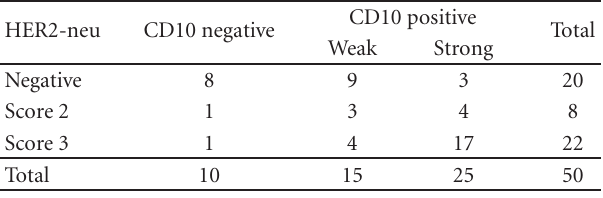
Figure 4: Strong CD10 stromal staining. Table 4: Correlation of CD10 with HER2-neu.